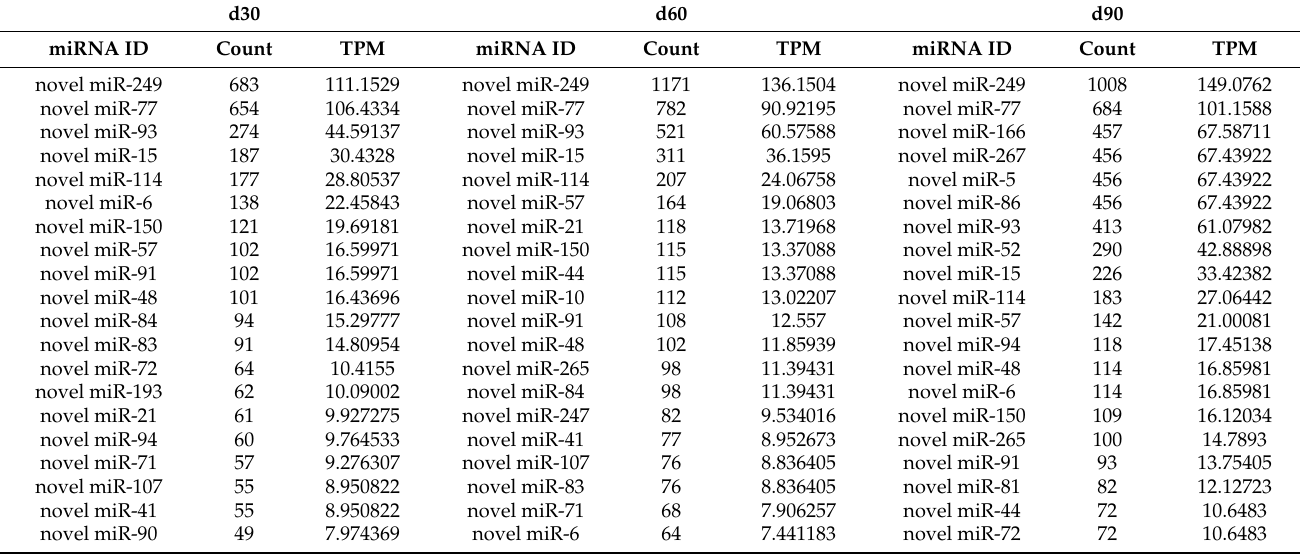
Table 3. The top 20 novel miRNAs with the highest expression abundance in antler growth centers at different growth